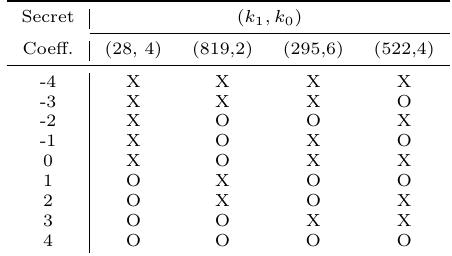
Table 8: Chosen pairs of ( k 1 , k 0 ) to determine s [ i ] based on m [ i ] for Saber without error correction. (X: m [ i ] = 1; O: m [ i ] = 0)